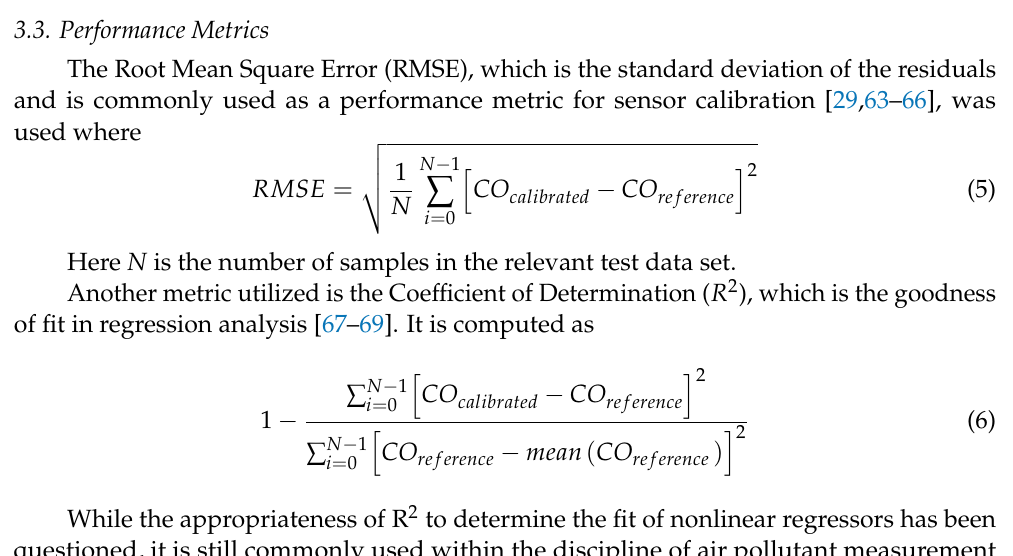
Figure 4. Example of training and validation losses for 1DCNN during k-fold cross-validation.